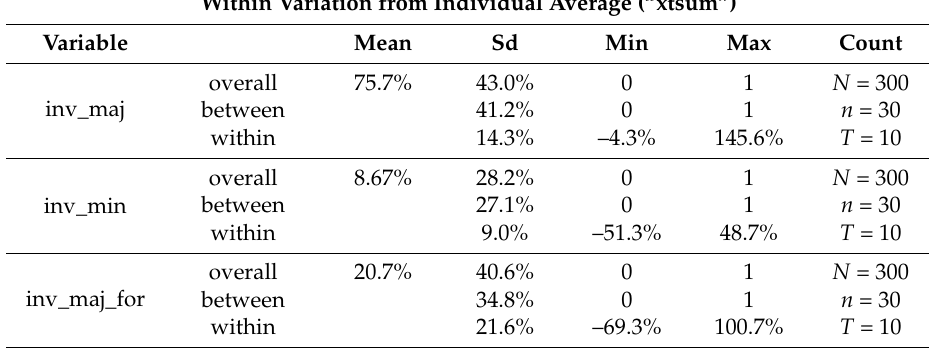
Table 7. Within variation of team